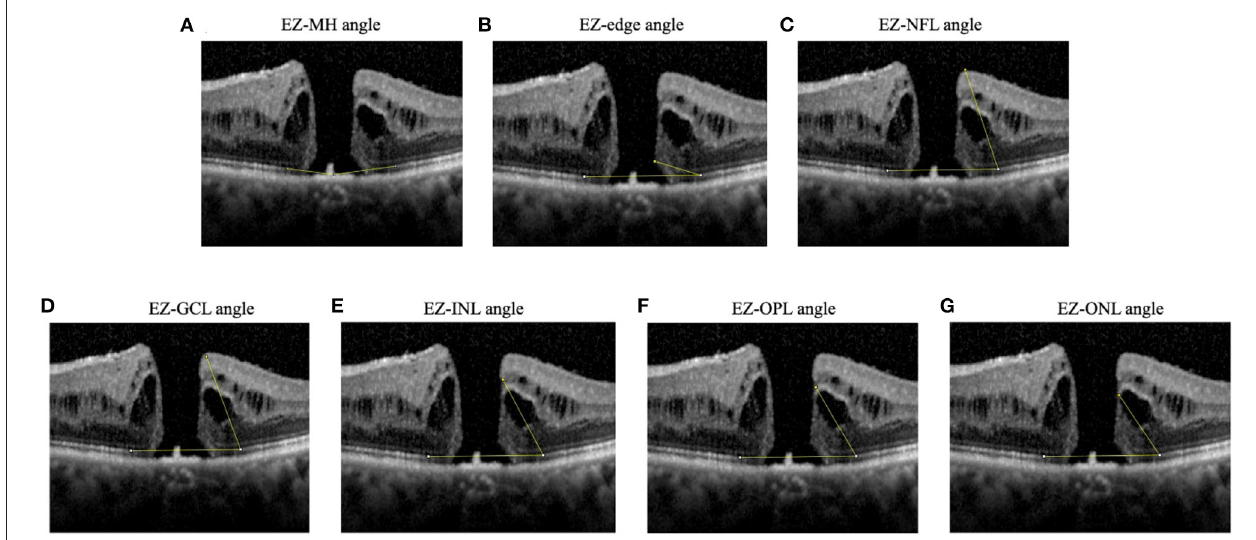
FIGURE 1 | Diagrams showing angles measured. (A) EZ-MH angle: the angle whose vertex located at the center of the hole and the endpoints of both sides were located at the anterior border of the EZ band edge, (B) EZ-edge angle: the angle between a line connecting the upper edge of the EZ band and a line through the most protruding point of either edge of the MH, (C) EZ-NFL angle, (D) EZ-GCL angle, (E) EZ-INL angle, (F) EZ-OPL angle, (G) EZ-ONL angle. The EZ-NFL, EZ-GCL, EZ-INL, EZ-OPL, and EZ-ONL angles were each between a line connecting the two upper edges of the EZ band, and a line through the upper edge of the respective band. If measurements were different between left and right hole edge, the smaller angle was recorded. EZ, ellipsoid zone; GCL, ganglion cell layer; INL, inner nuclear layer; NFL, nerve fiber layer; ONL, outer nuclear layer; OPL, outer plexiform